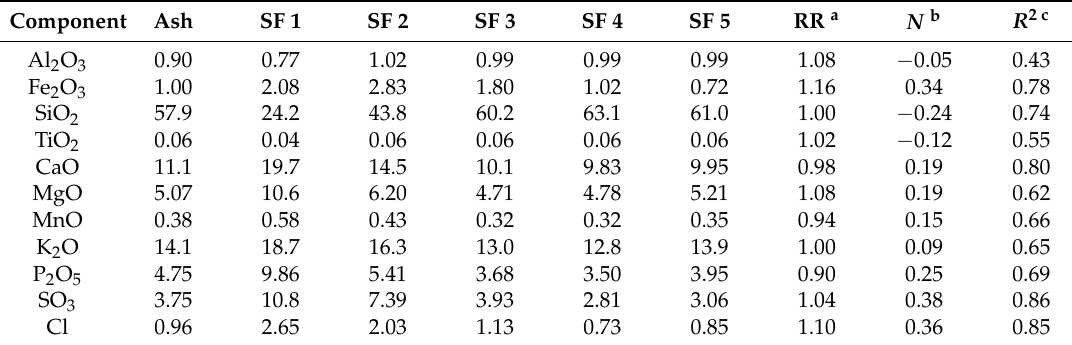
Table 2. Concentration of main components in the fly ash size fractions (in % d.m.). Component